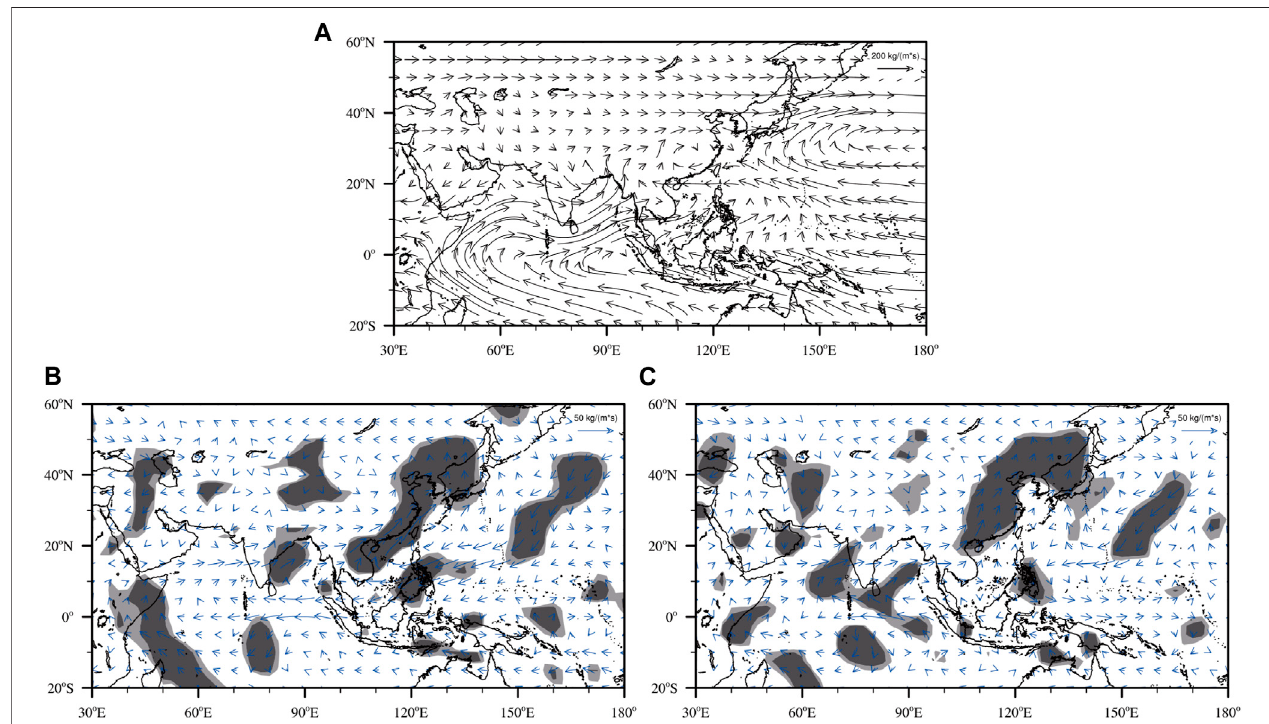
FIGURE6|(A) ClimatologyofSeptemberverticallyintegratedmoisturetransportfor1961 – 2020andregressedSeptemberverticallyintegratedmoisturetransport (unit: kg · m − 1 s − 1 ; vectors) onto (B) the SCPI and (C) the APOI (shading indicates areas signi fi cant at the 95% (dark) and 90% (light) con fi dence